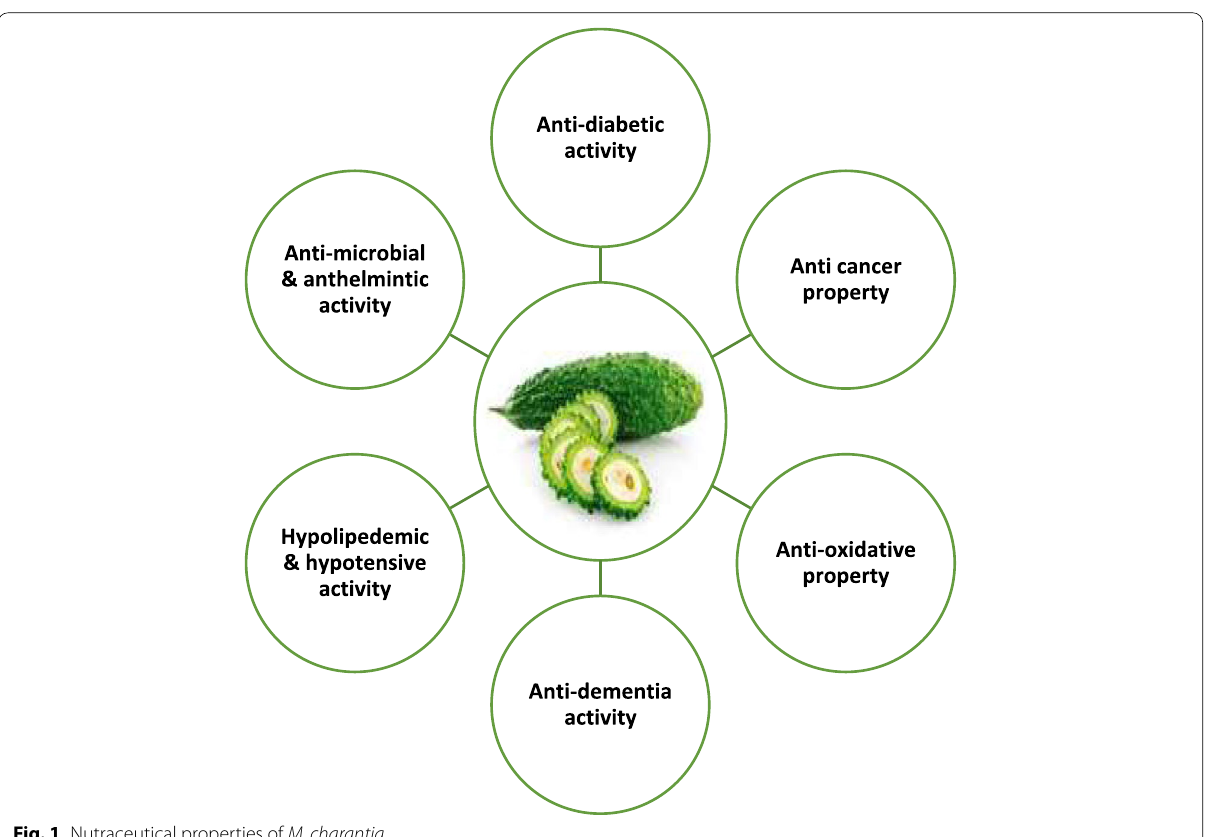
Fig. 1 Nutraceutical properties of M.